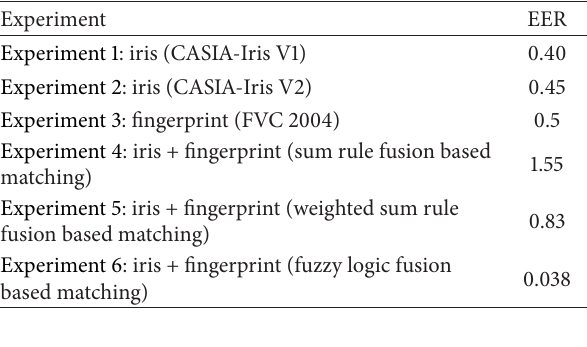
Table 8: Equal error rate comparison.